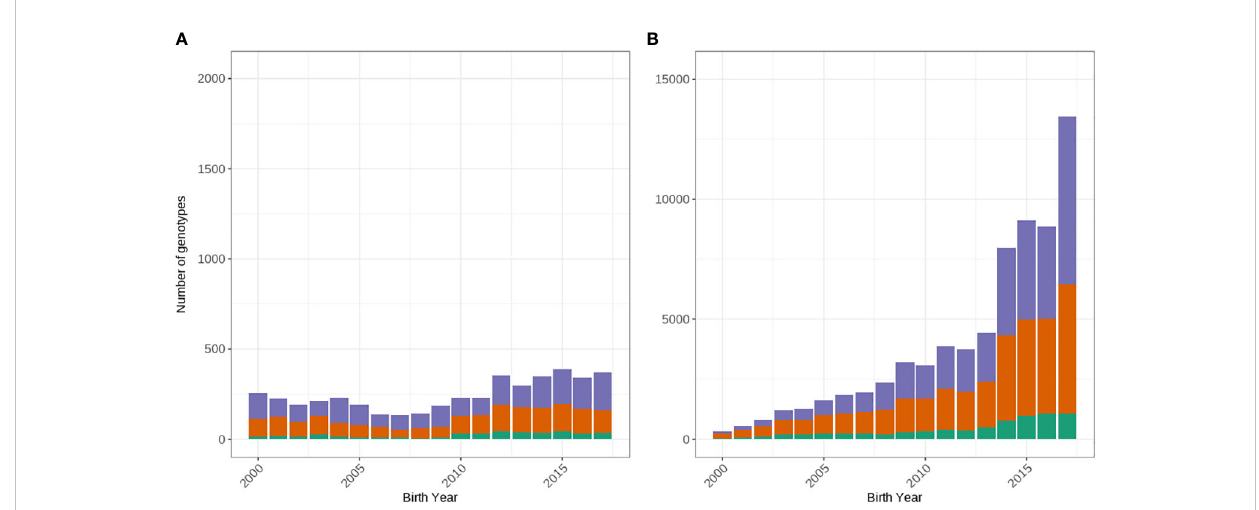
FIGURE 1 Distribution of genotypes by year of birth from 2000 to 2017 for the A1/A1 (green), A1/A2 (orange) and A2/A2 (purple) b -Casein loci for males (A) and females (B)